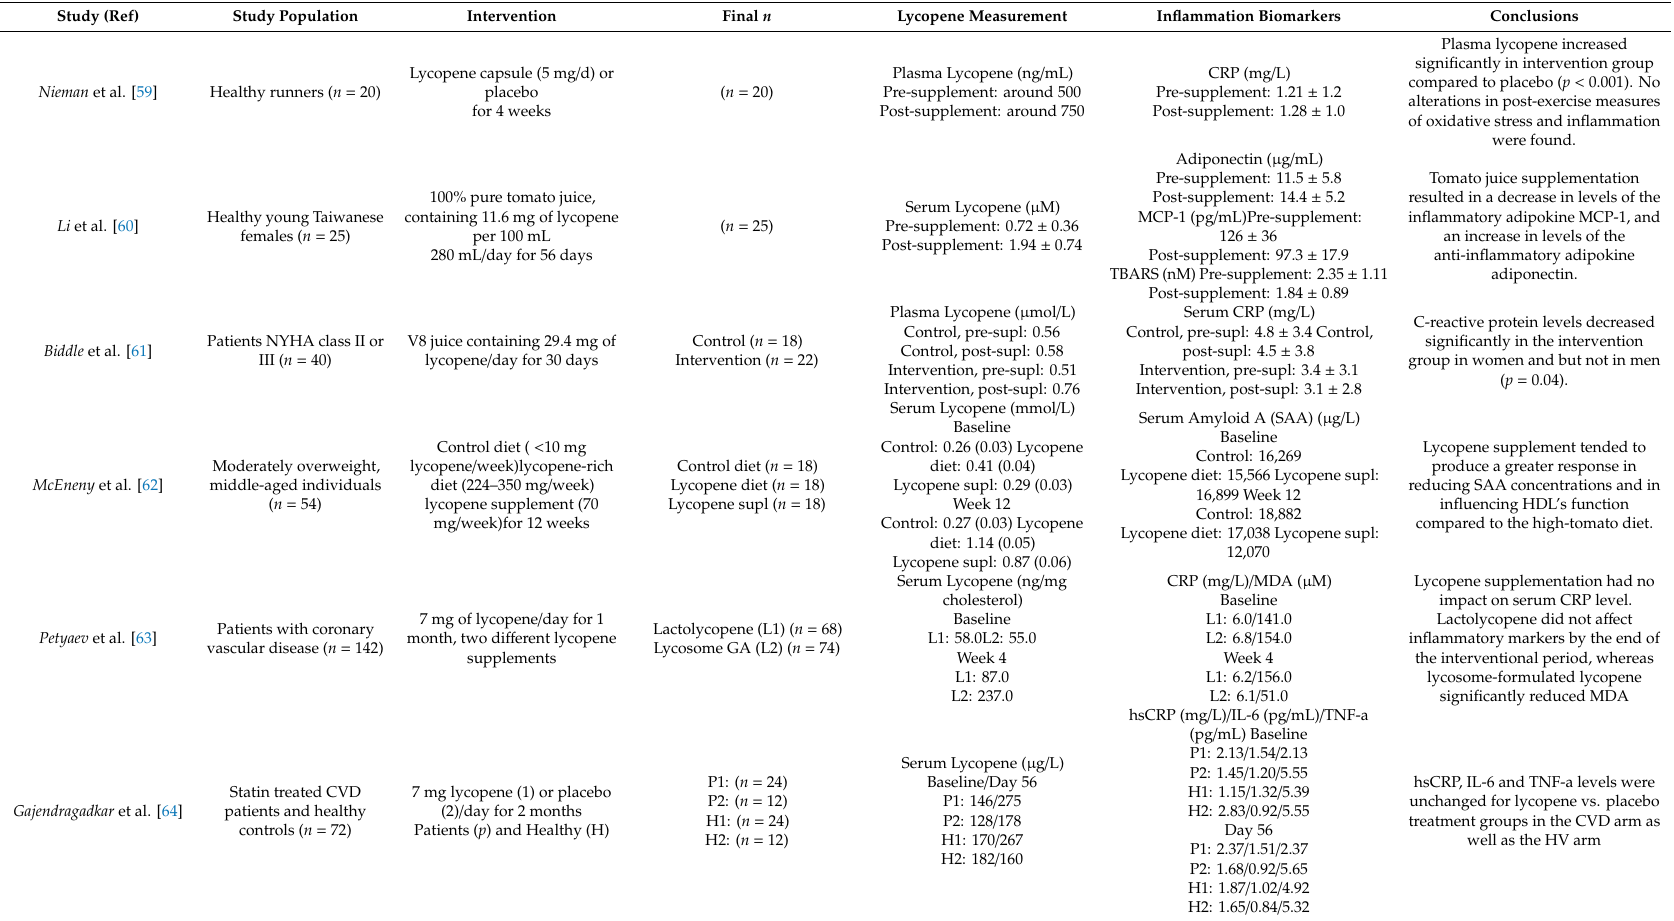
Table 2. Intervention studies assessing the influence of lycopene supplementation on